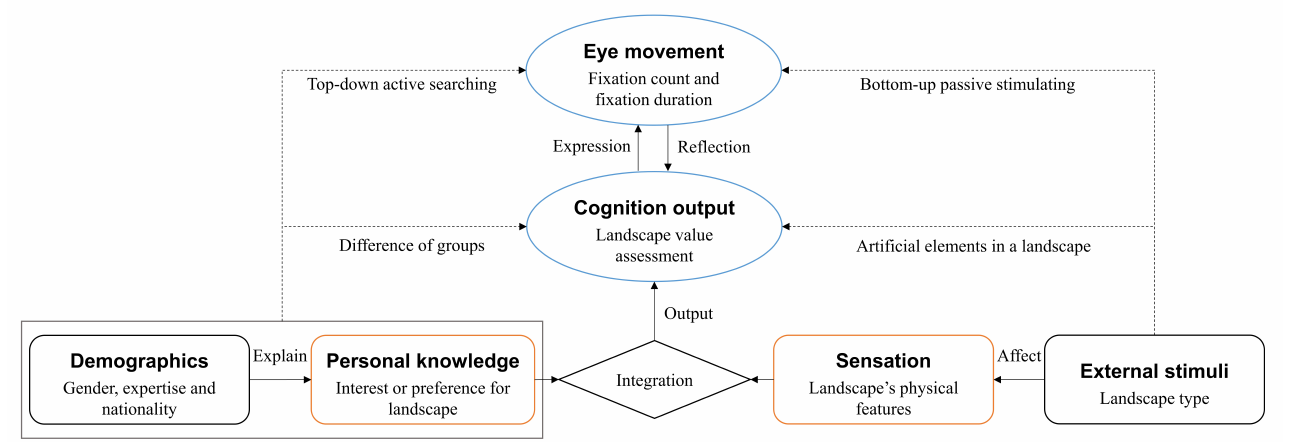
Figure 1. Conceptual framework of landscape